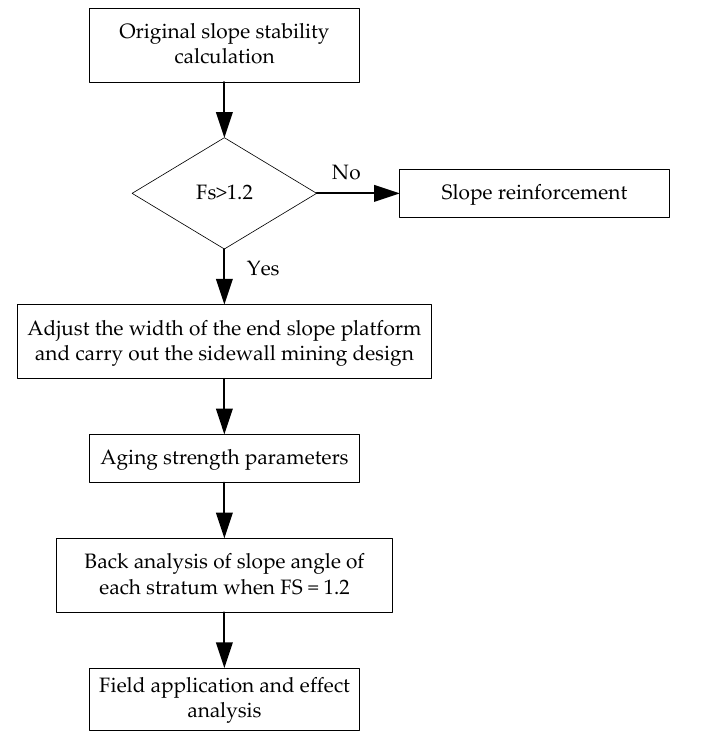
Figure 9. Design flowchart of aging slope.